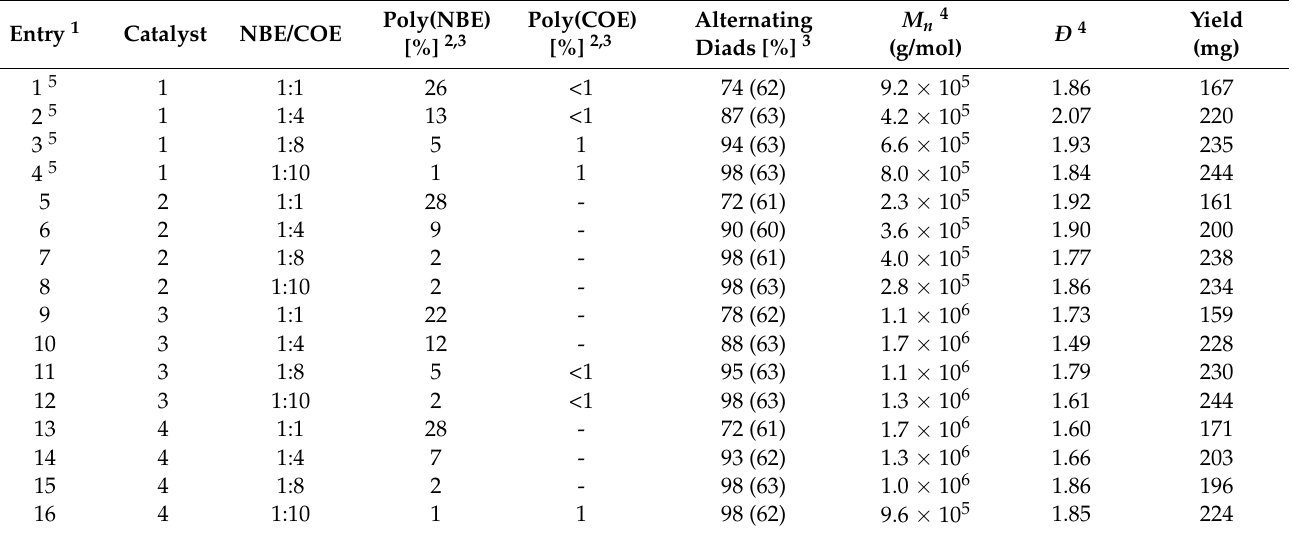
Table 1. ROMP copolymerization of NBE and COE in the presence of catalysts 1 - 4 .